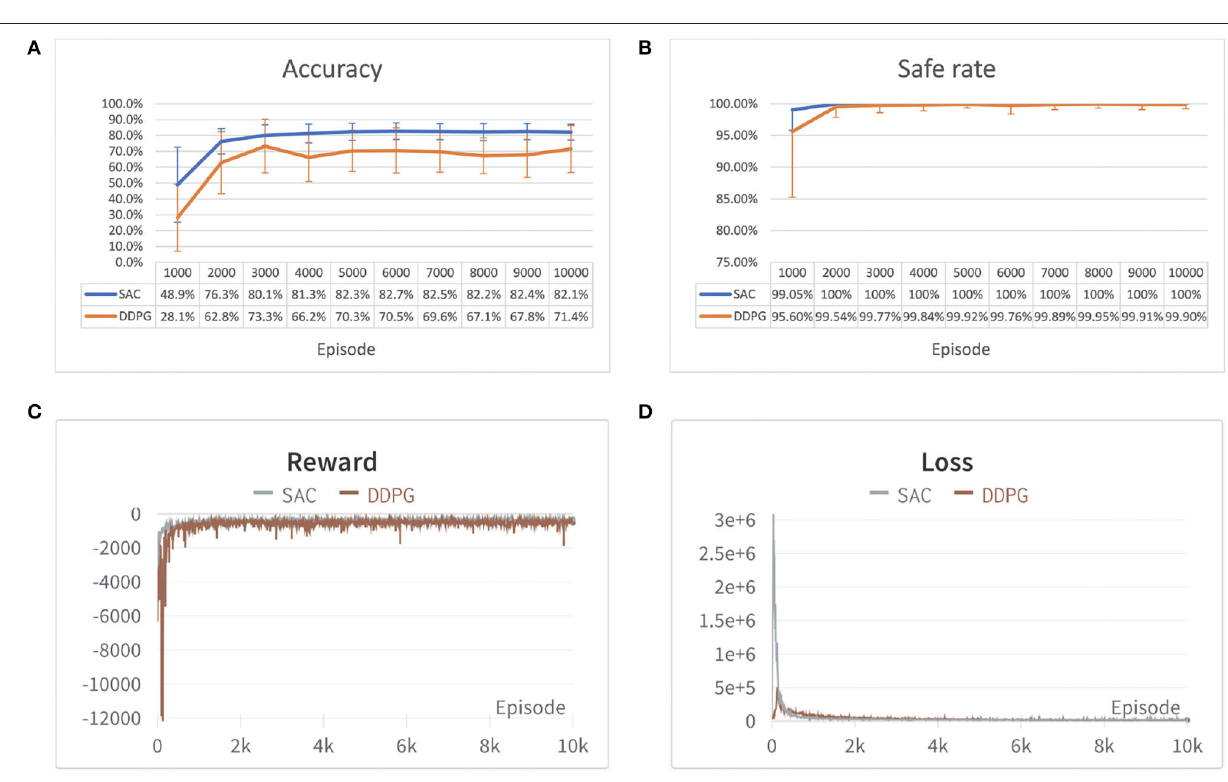
FIGURE 7 | Performance comparison of SAC and Deep Deterministic Policy Gradient (DDPG) algorithm in the first environment. (A) Accuracy of different algorithms shown in error bar line graph. (B) A safe rate of different algorithms in the error bar line graph. (C) The cumulative reward for each episode. (D) Loss for each episode. Each episode corresponds to 100 time